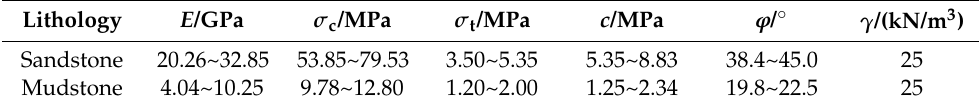
Table 1. Mechanical parameters of prototype materials.